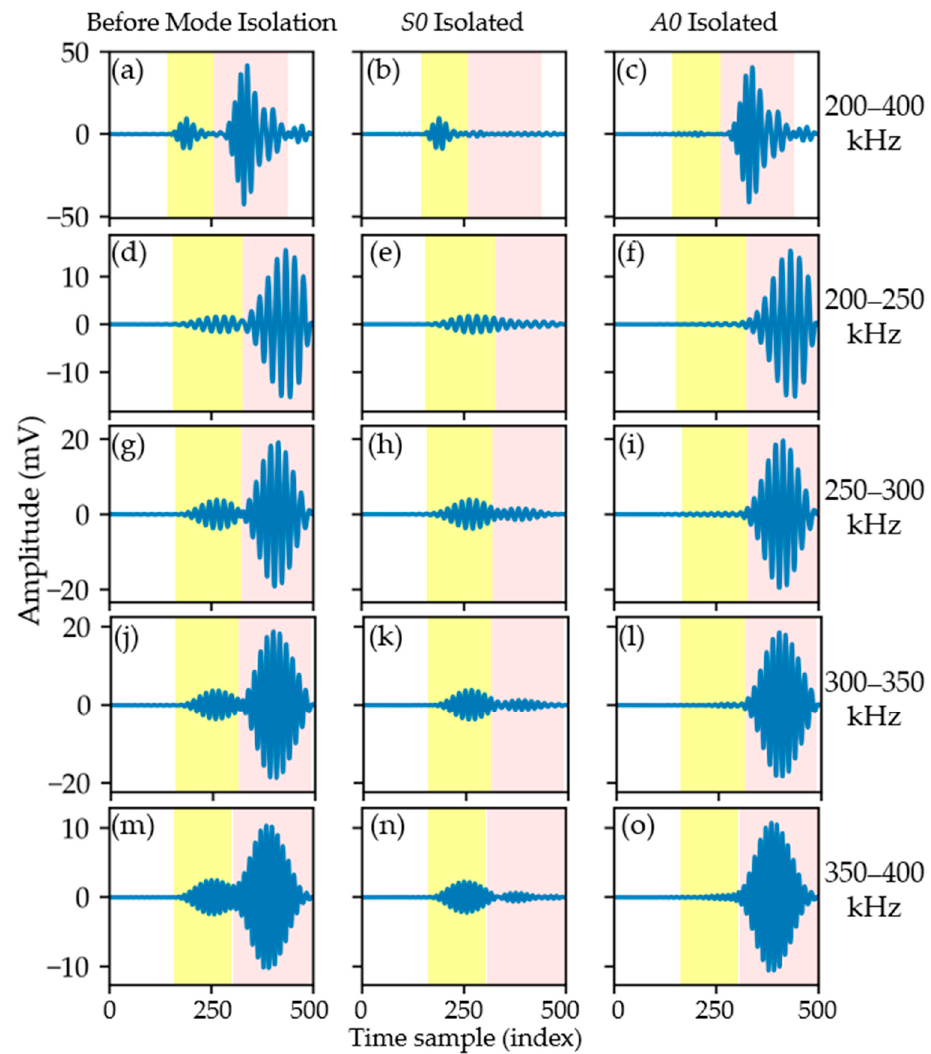
Figure 6. An example of time-domain signal taken from the data of inspection Case P1. The left, middle, and right columns show the signals before mode isolation, after S0 mode isolation, and after A0 mode isolation, respectively. Sub-figures ( a – c ) show the as-acquired broadband signal, while sub-figures ( d – o ) show the signals after being software-filtered at different frequency bandpass ranges, as indicated at the far right. Time zones with a yellow and pink background were used for the ER calculation of S0 mode and A0 mode, respectively.